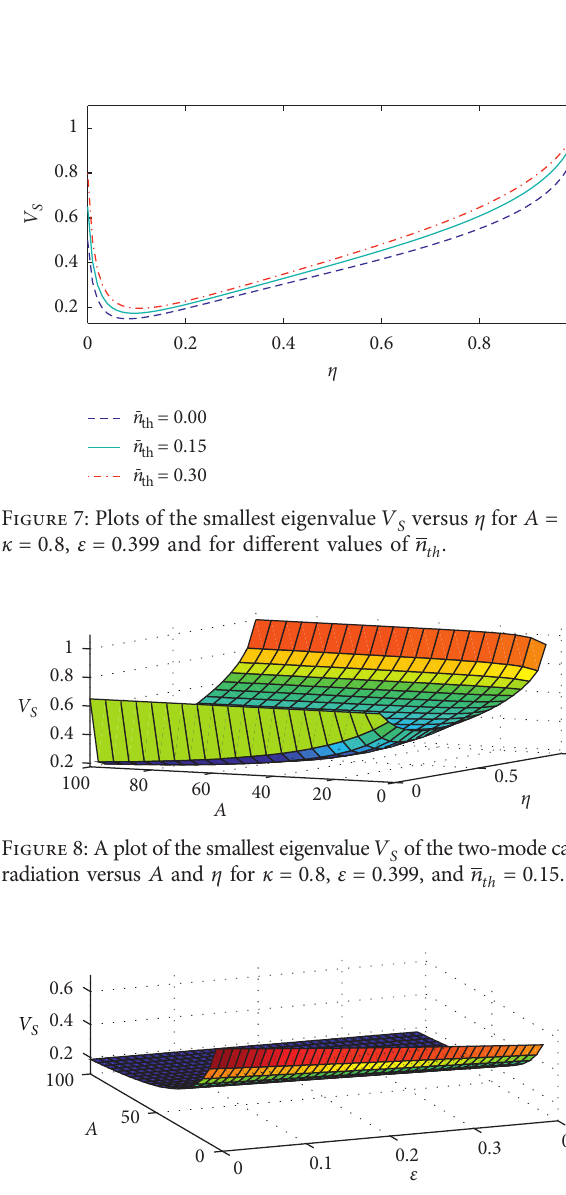
Figure 9: A plot of the smallest eigenvalue V cavity radiation versus A and ε for κ � 0 . 8, n th � 0 . 15, and η � 0 . 1.